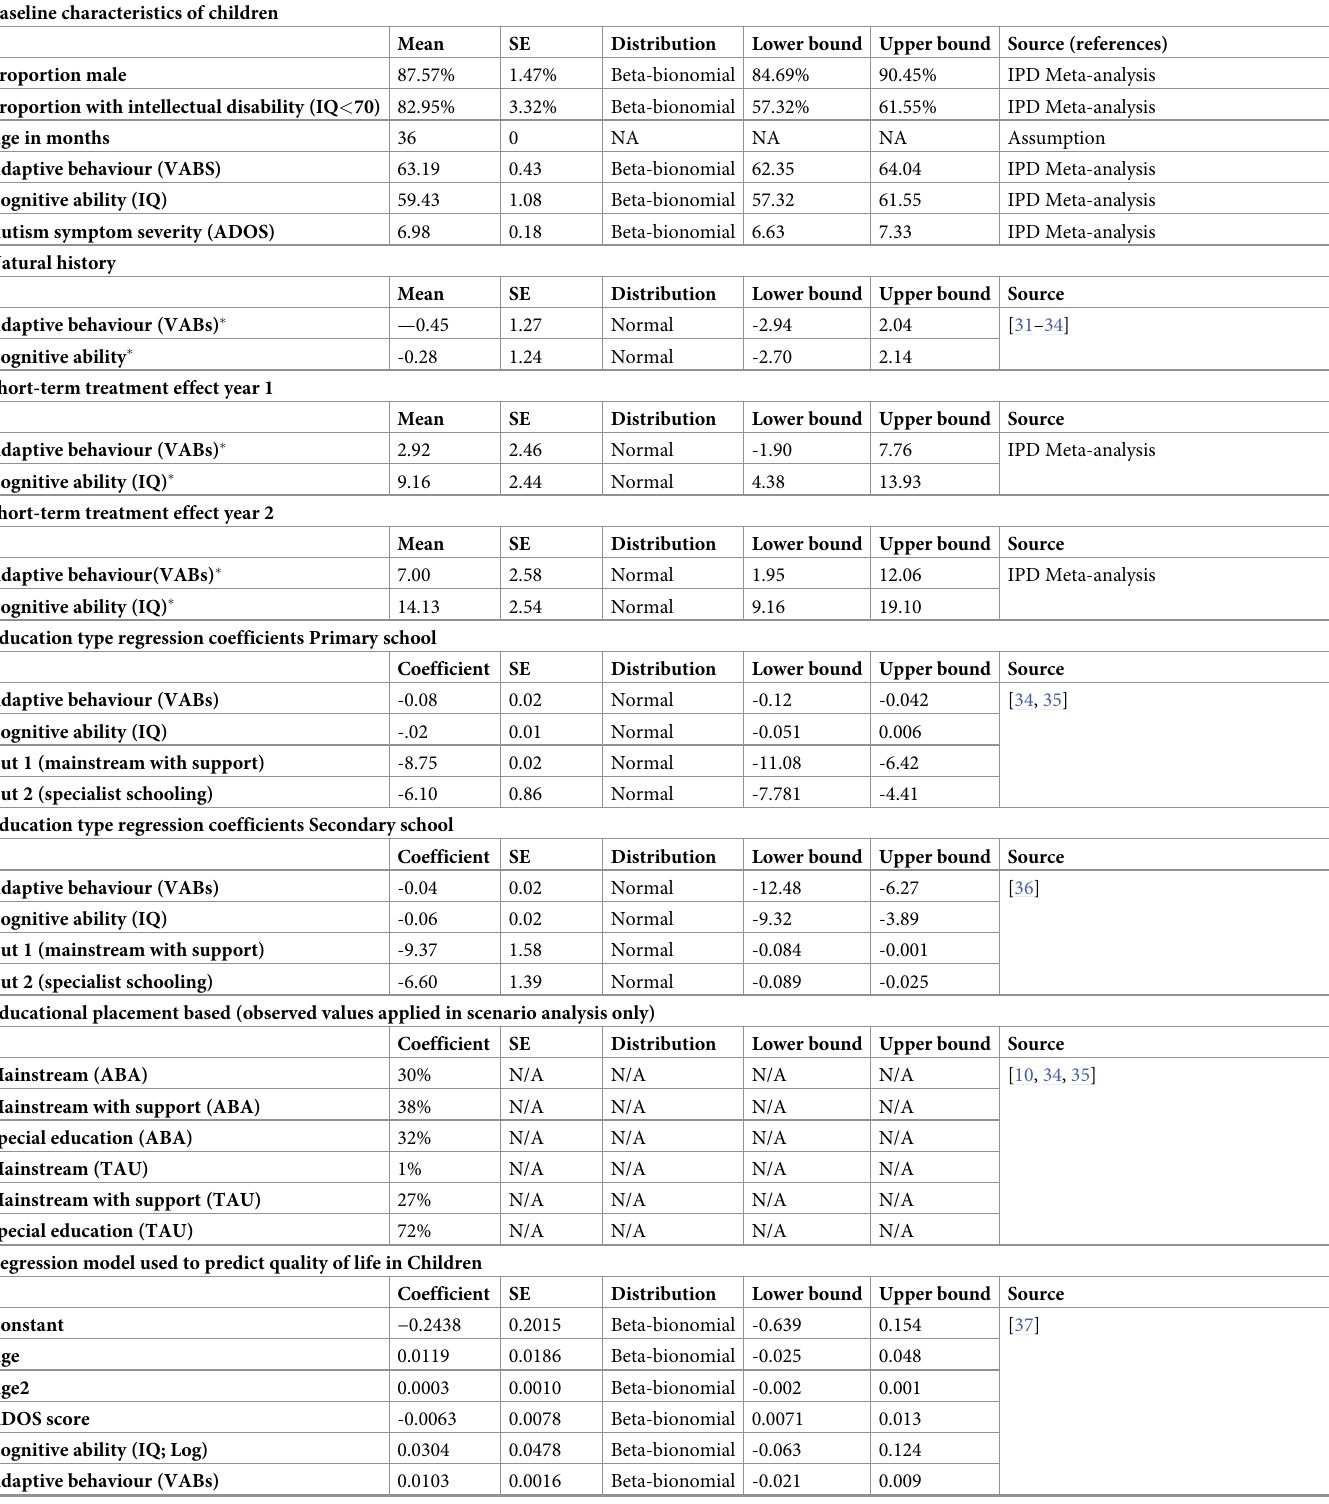
Table 1. Parameter inputs used in the economic